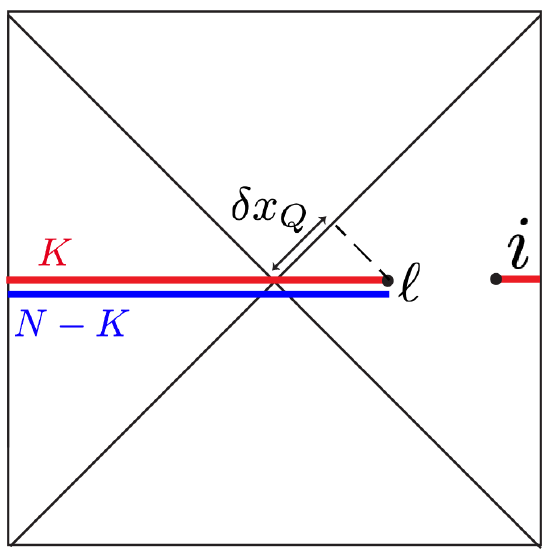
Figure 2. We illustrate the putative bulk picture that we test in section 6. We imagine a bulk with N free fermions of mass set by the boundary dimensions of the SYK fermions in the IR limit. We then imagine finding a QES in the bulk associated to L ∪ K by fixing a small interval i , associated with the K fermions on the right, and then extremizing the generalized entropy for ‘ ∪ i where only the K fields are included in the entropy for ‘ ∪ i . The remaining N − K fields only contribute to the entropy in ‘